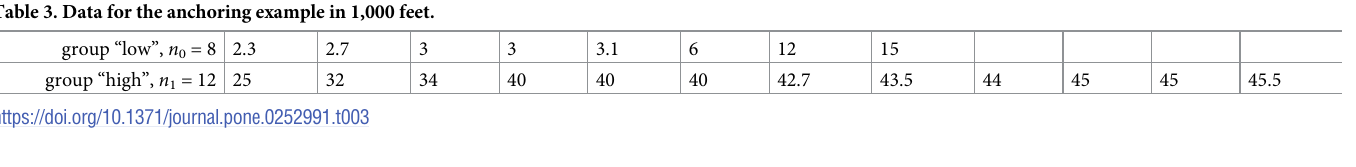
According to the discussion in Section 5, the data is analyzed here on the logarithmic scale,